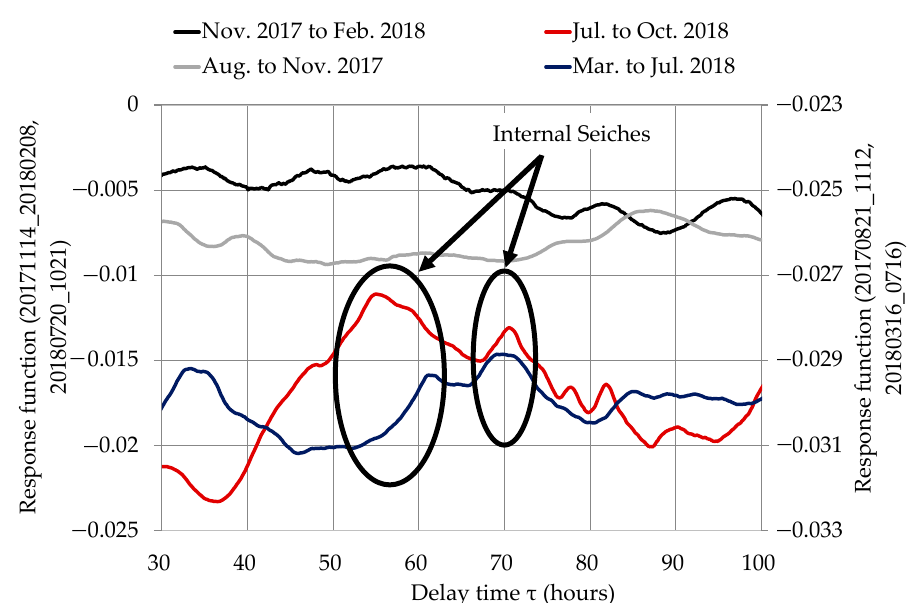
Figure 4. Calculated water-level response functions with respect to average precipitation from August 2017 to October 2018, showing τ < 25 h. The circled peaks were considered internal seiches. These functions were calculated using MATLAB software, and the figure was drawn using Microsoft Excel.